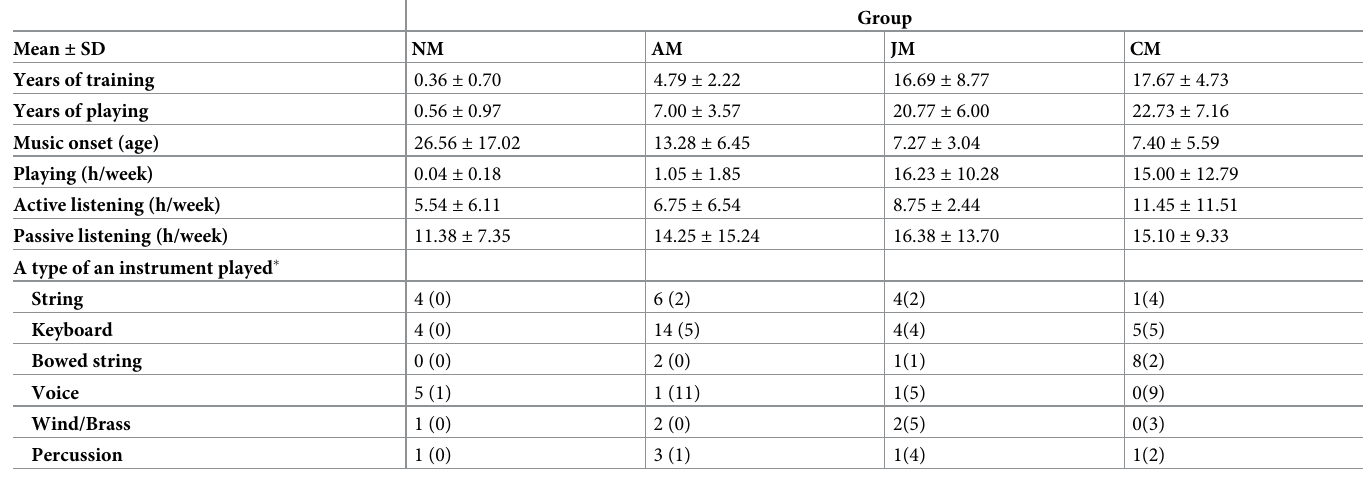
Table 1. Musical